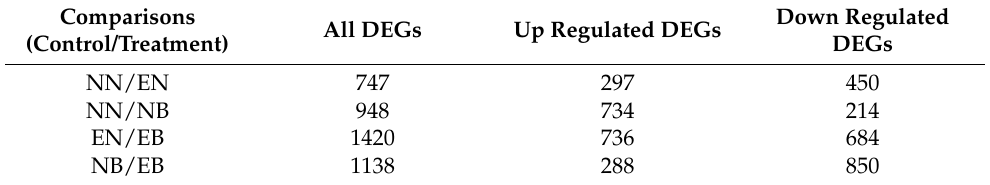
Table 2. The number of differentially expressed genes (DEGs) in the four comparison groups.